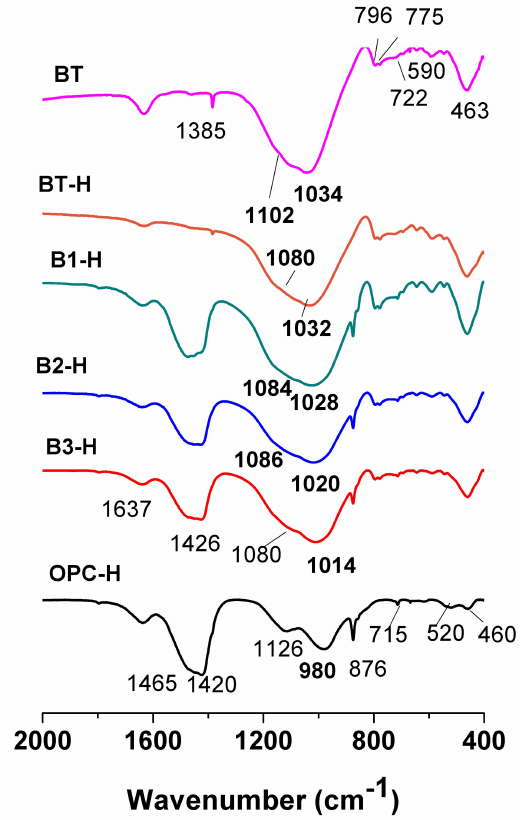
Figure 4. FTIR Spectra for hydrated systems BT, OPC, B1, B2 and B2 (2 days) from 2000 cm − 1 to 400 cm − 1 without activator